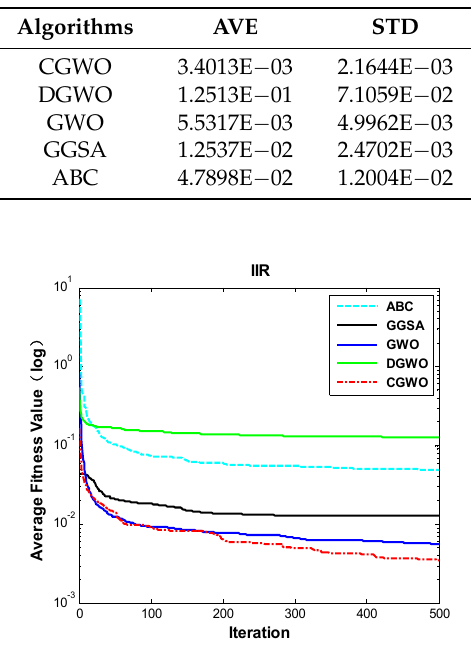
Figure 6. Comparison between CGWO and the other algorithms for IIR system identification.